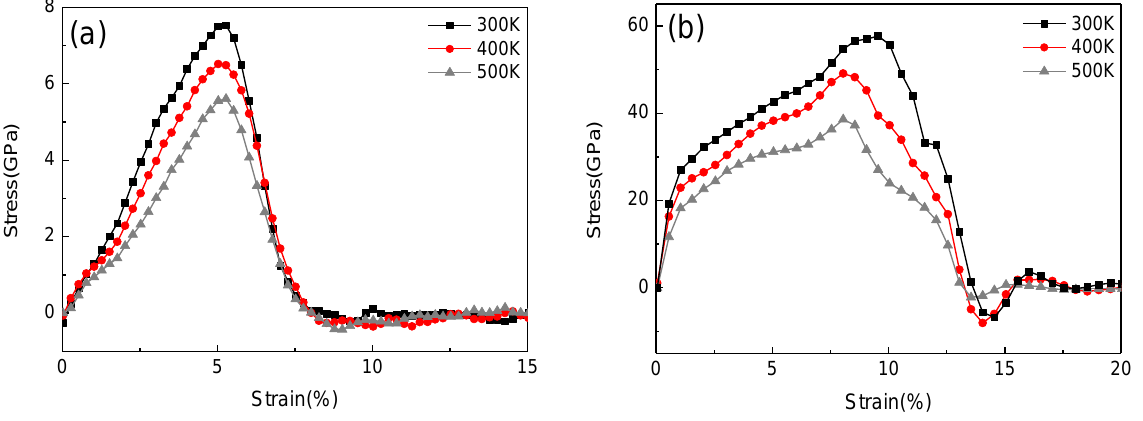
Figure 2. Stress-strain relationship at different temperatures. ( a ) Pristine CNCs. ( b ) CNCs-graphene layered composite.